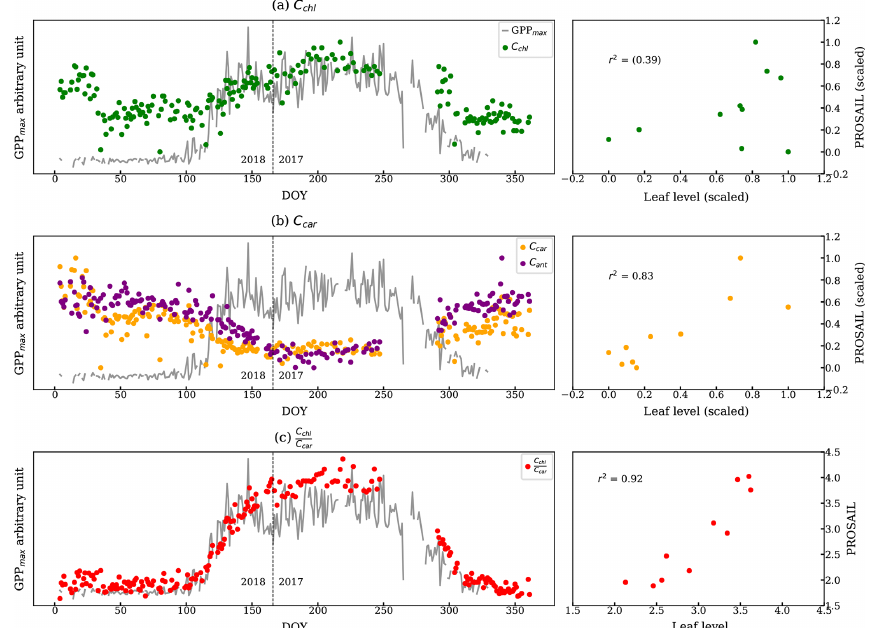
Figure 8. The left panels are the estimations of (a) C chl , (b) C car , C ant , and (c) C chl from the PROSAIL overlaid with the GPP max . We C car normalized two metrics because they report the pigment contents in different units. The vertical dashed line divides the observations from DOY for the years 2017 and 2018. The plots on the right compare the pigment contents from leaf-level measurements and using PROSAIL: